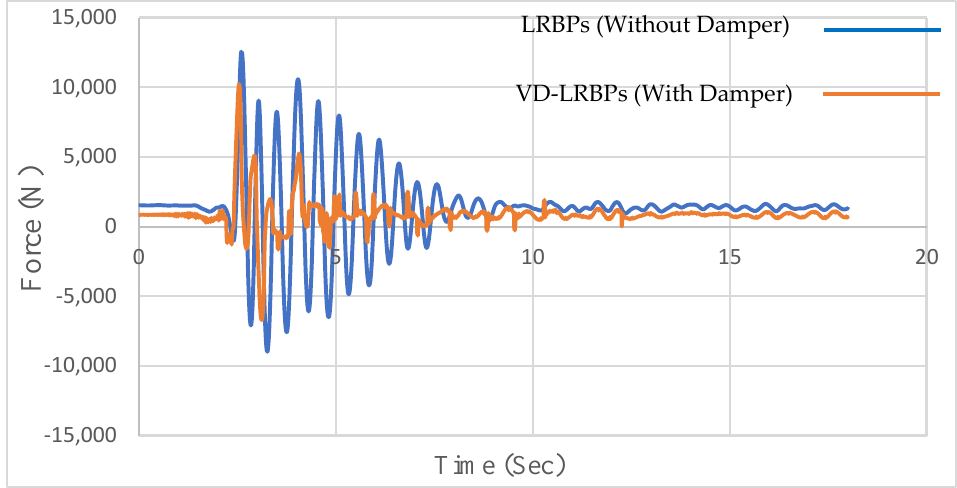
Figure 25. Force histories that pier one experiences under the Imperial Valley (El Centro) earth- quake.